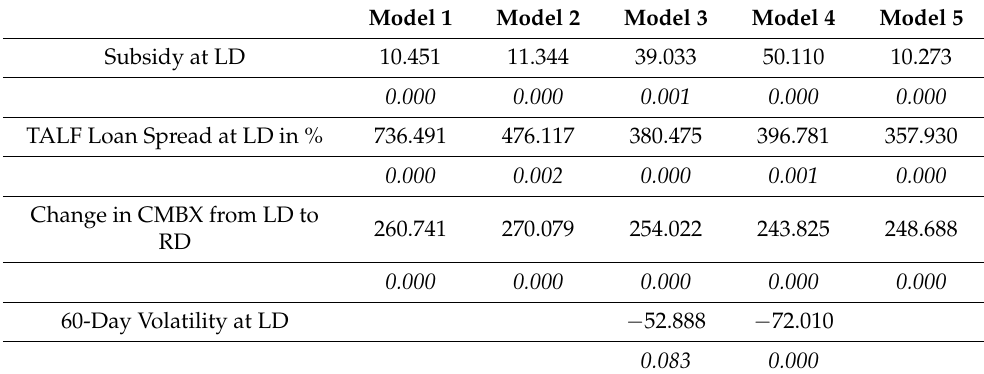
Table 5. Logistic regression of factors associated with early repayment of TALF loans to purchase